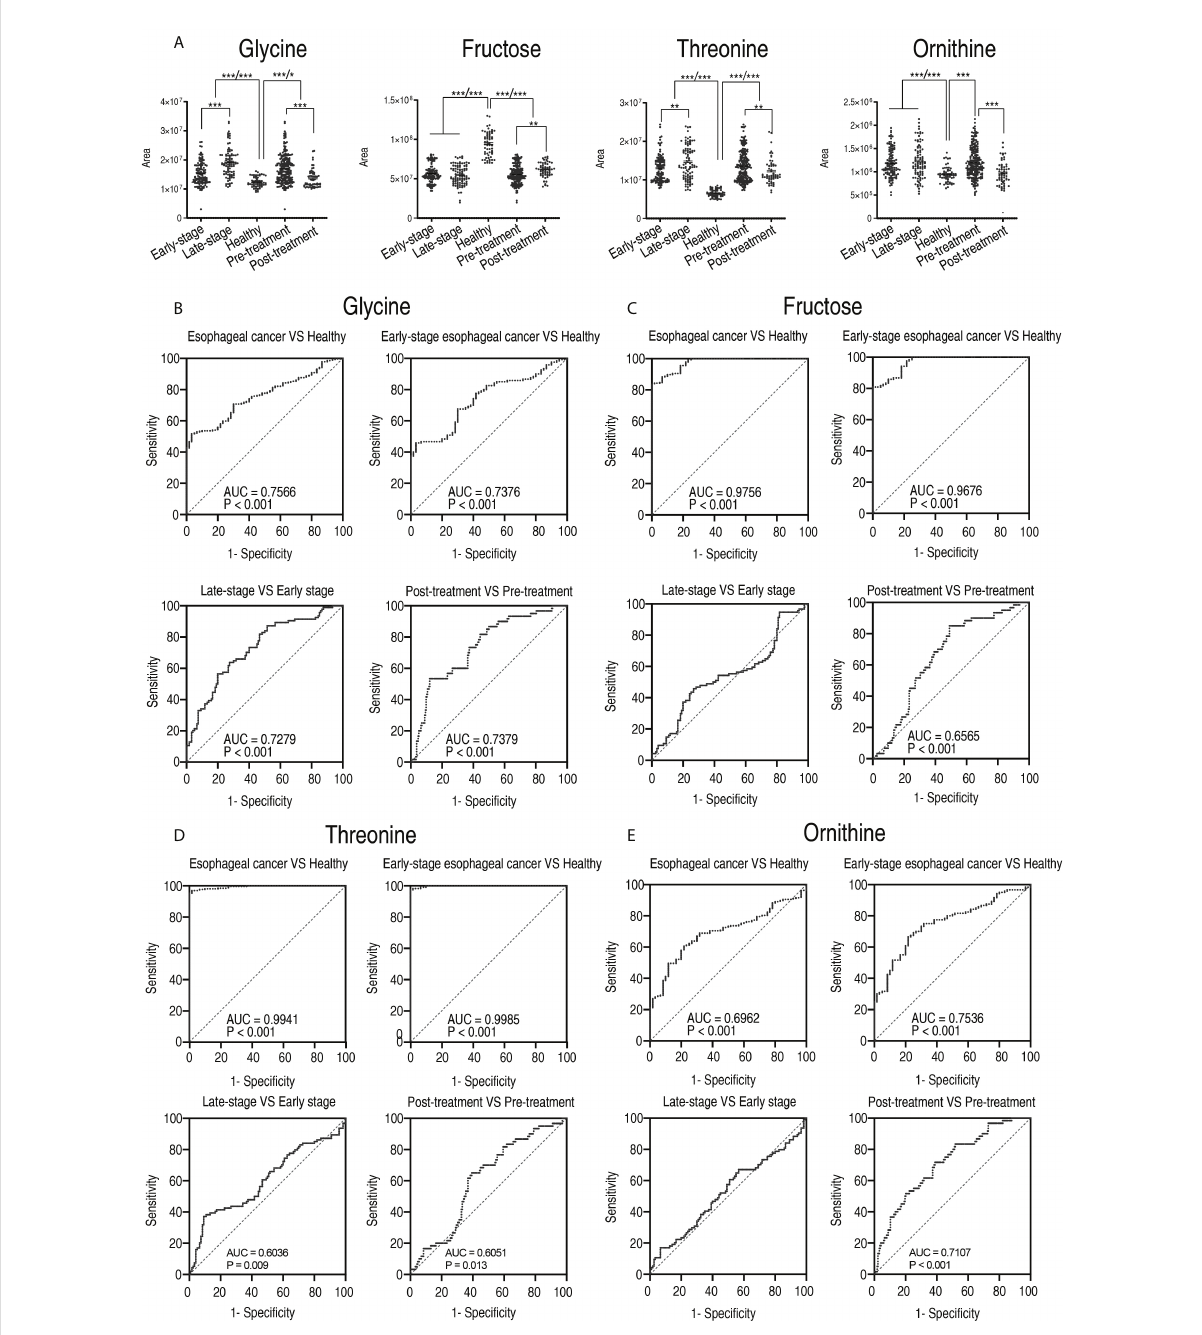
FIGURE 10 The clinical potential of glycine. (A) Comparison of glycine, fructose, threonine, and ornithine between healthy subjects and patients with early stage and late stage of esophageal cancer, and between healthy subjects, patients who received treatment (post-treatment), and patients who did not receive treatment (pre-treatment). Results are displayed as mean ± SEM, * p < 0.05, ** p < 0.01, and *** p < 0.001 as determined by Student ’ s t -test. (B – D) ROC curves to distinguish esophageal cancer patients from normal individuals, early-stage esophageal cancer patients from healthy subjects, late-stage esophageal cancer patients from early-stage esophageal cancer patients, and post-treatment patients from pre-treatment by glycine (B) , fructose (C) , threonine (D) , and ornithine (E) ,